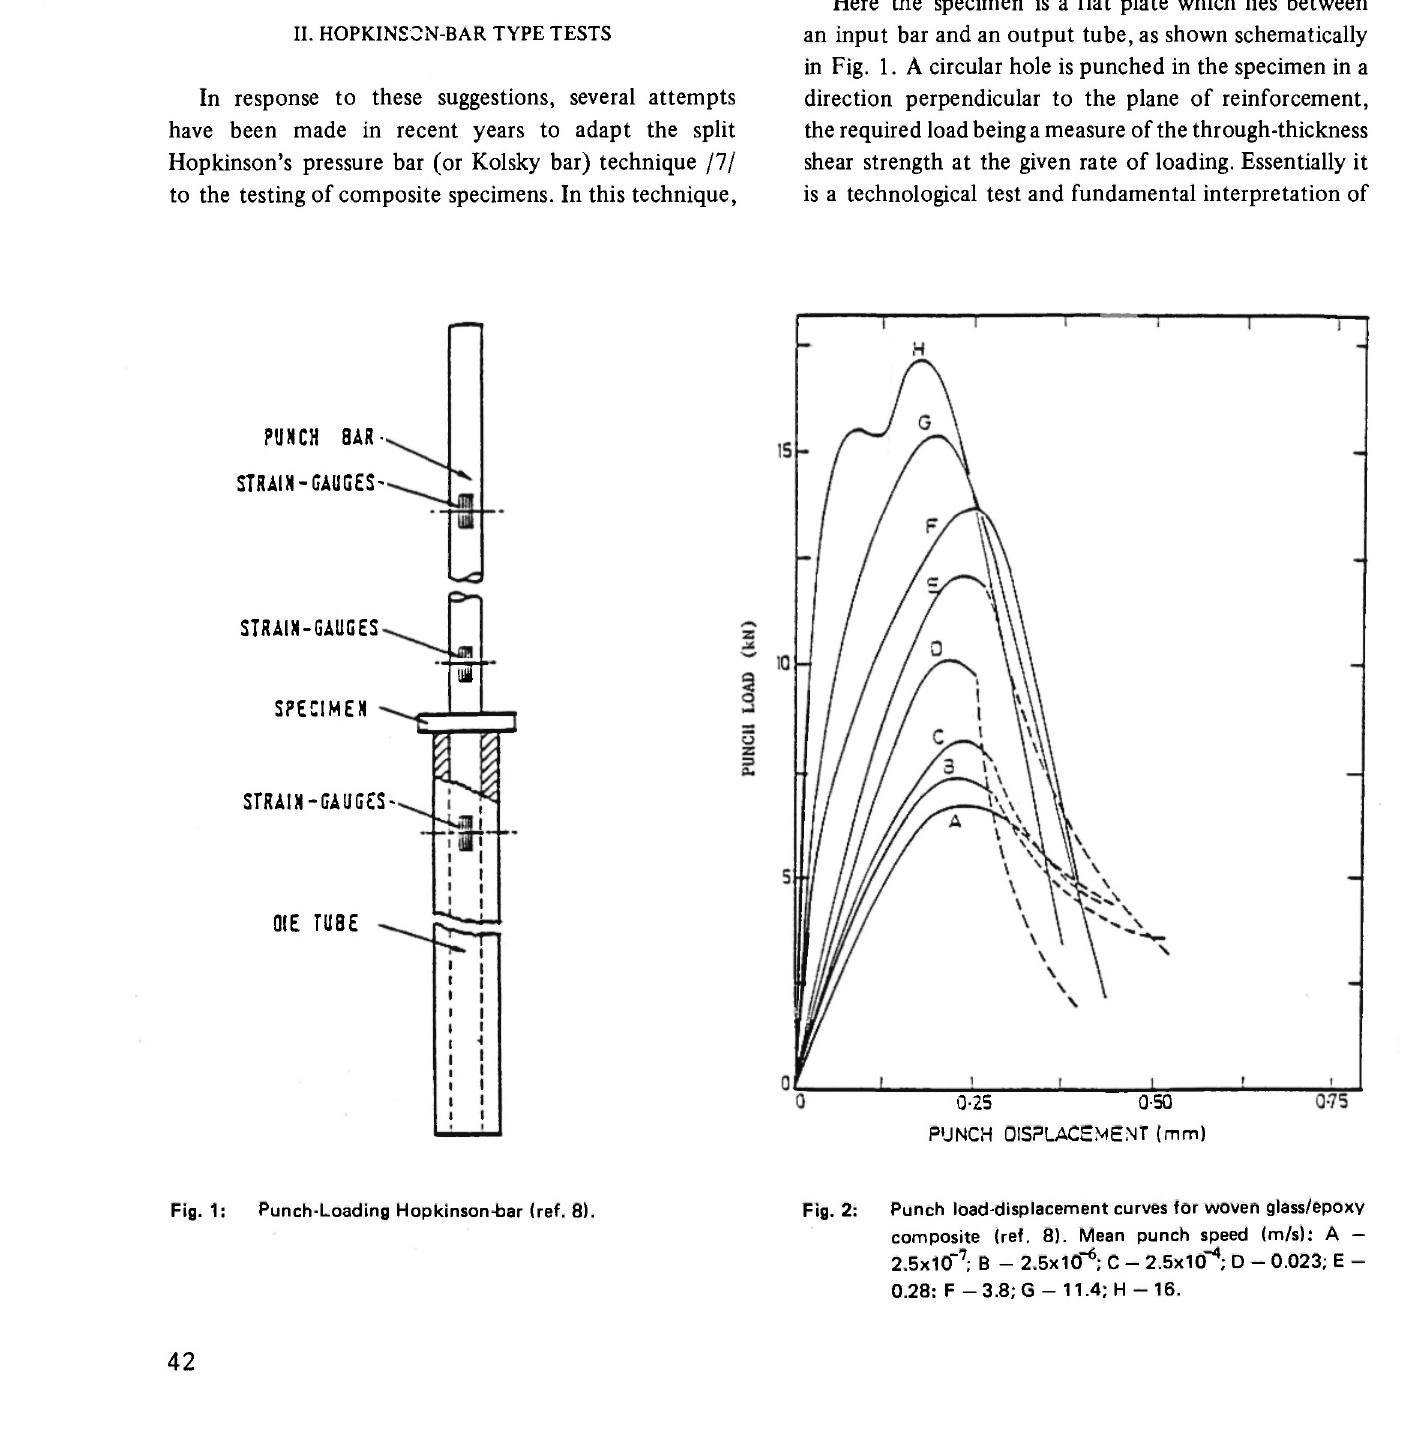
composite (ref. 8). Mean punch speed (m/s): A — 2.5x10 -7 ; Β - 2.5x1ο -6 ; C - 2.5x1ο" 4 ; D - 0.023; Ε - 0.28: F - 3.8; G - 11.4; Η -